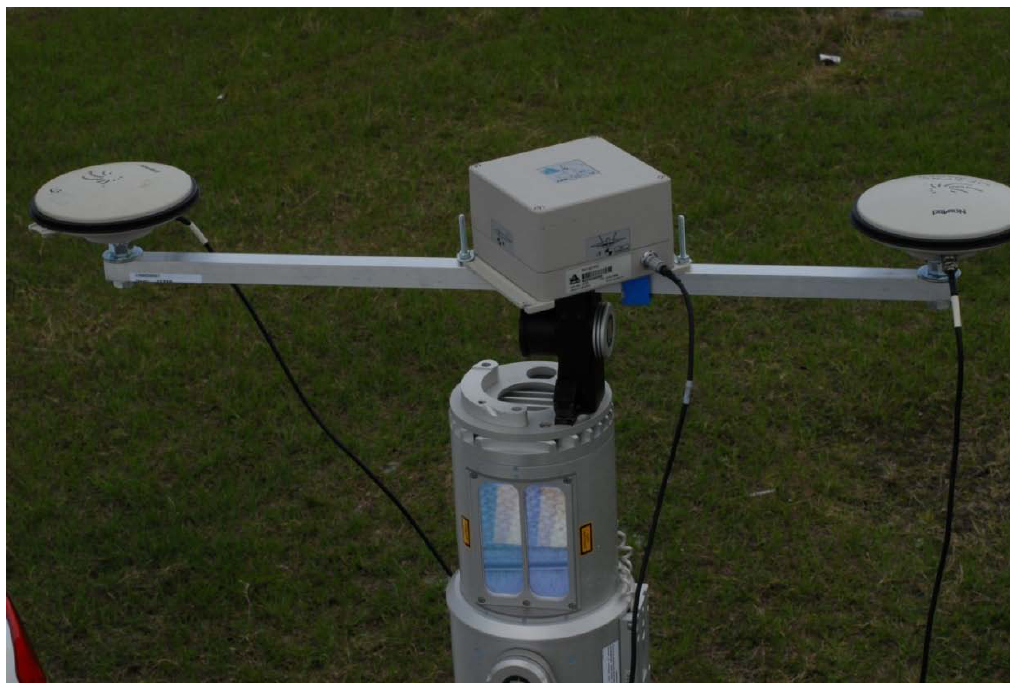
Figure 2. Experimental Setup of the Dual-Antenna System (DAS): Two GPS antennae fixed on a metal bar mounted on top of the LiDAR rotating sensor head. The Inertial Measuring Unit (IMU) in the middle of the setup is for check purpose only and is not part of the DAS